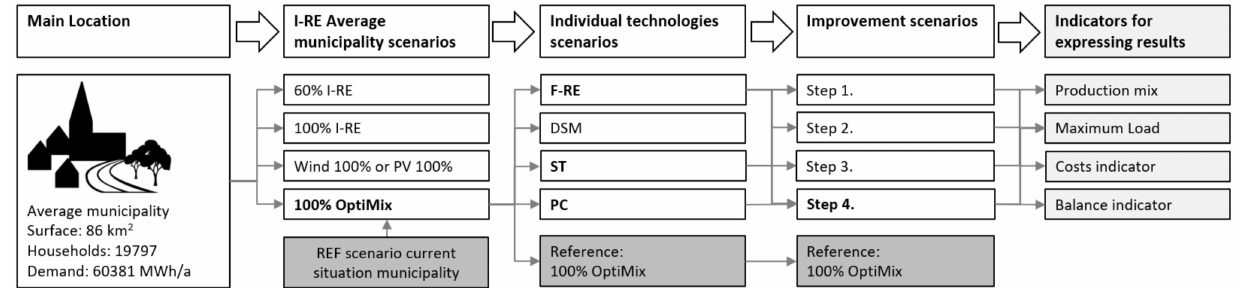
Figure 4. Main scenarios used within this article.